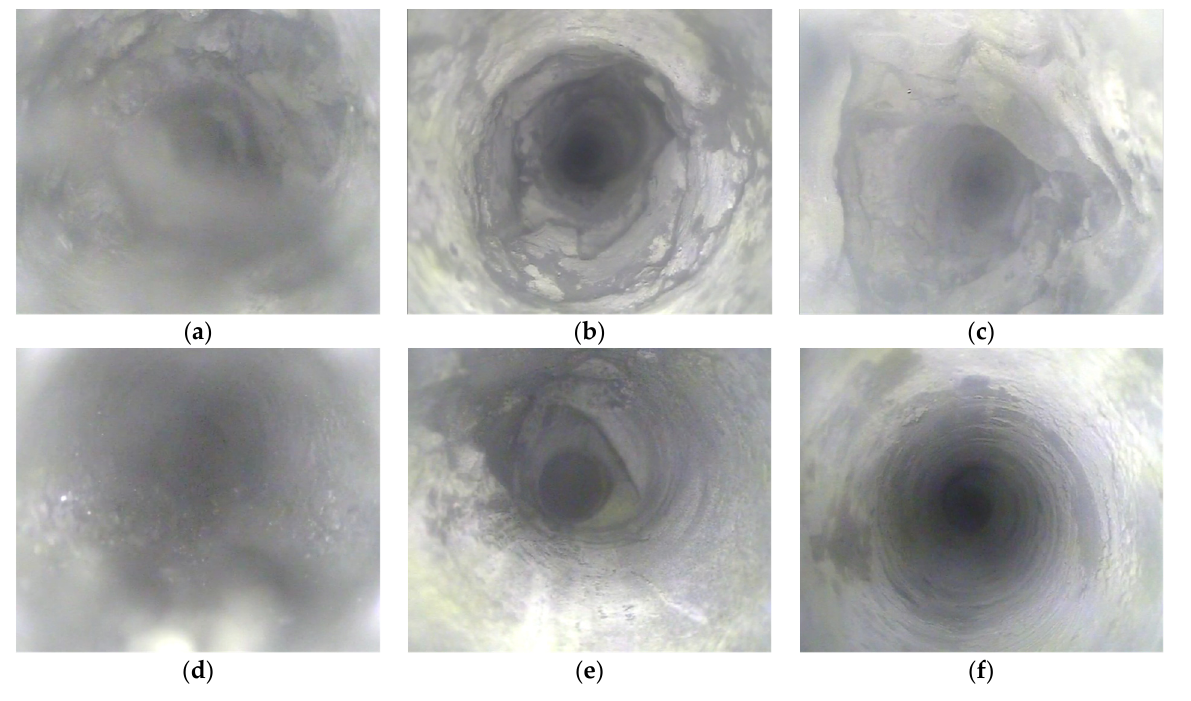
Figure 12. Comparison diagram of drillholes in grouting and non-grouting area under CUSG support. ( a ) Non-grouting gob, ( b ) non-grouting roof, ( c ) non-grouting coal wall, ( d ) grouting gob, ( e ) grouting roof, ( f ) grouting coal wall.